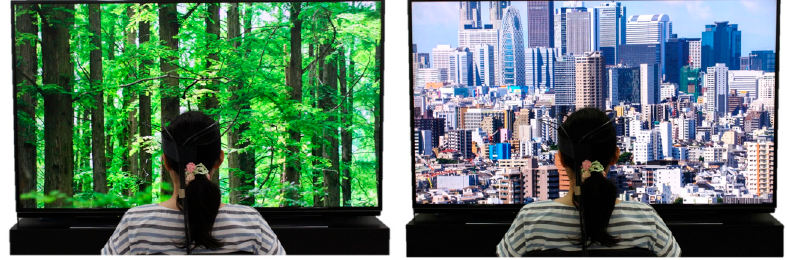
Figure 1. The scene during visual stimulation: ( left ) forest image; ( right ) city image.